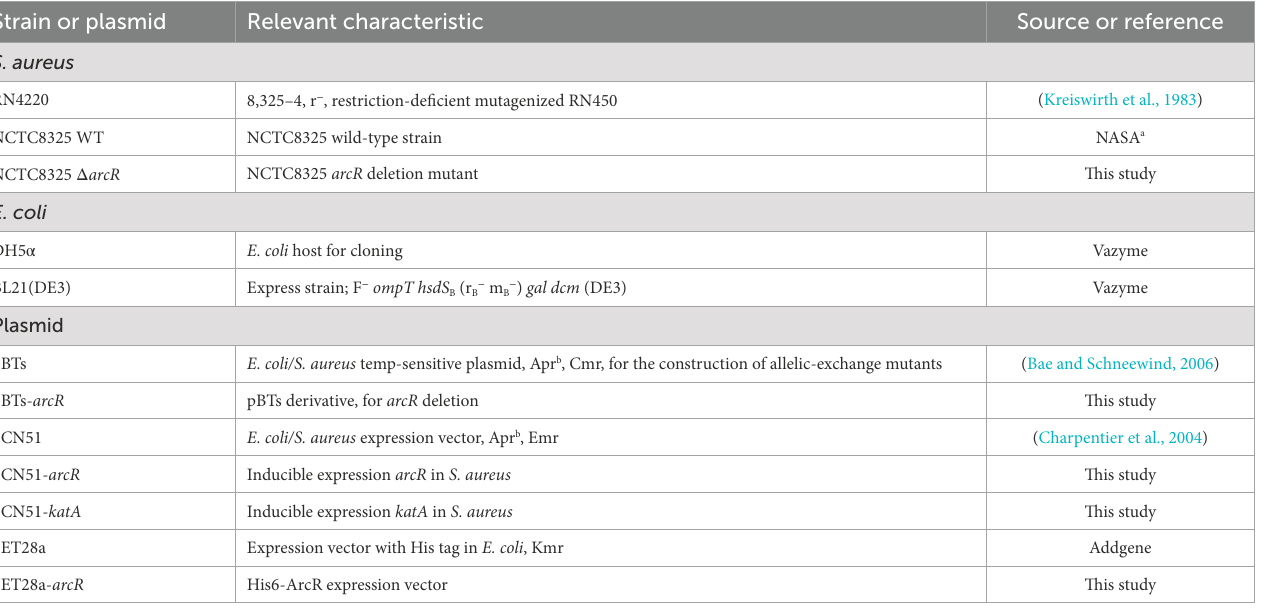
corresponding antibiotics (100 μ g/ml ampicillin and 50 μ g/ml